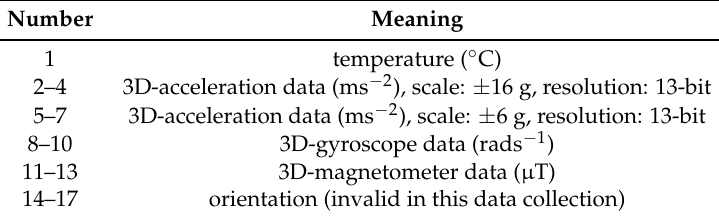
Table 3. The meaning of each column in IMU